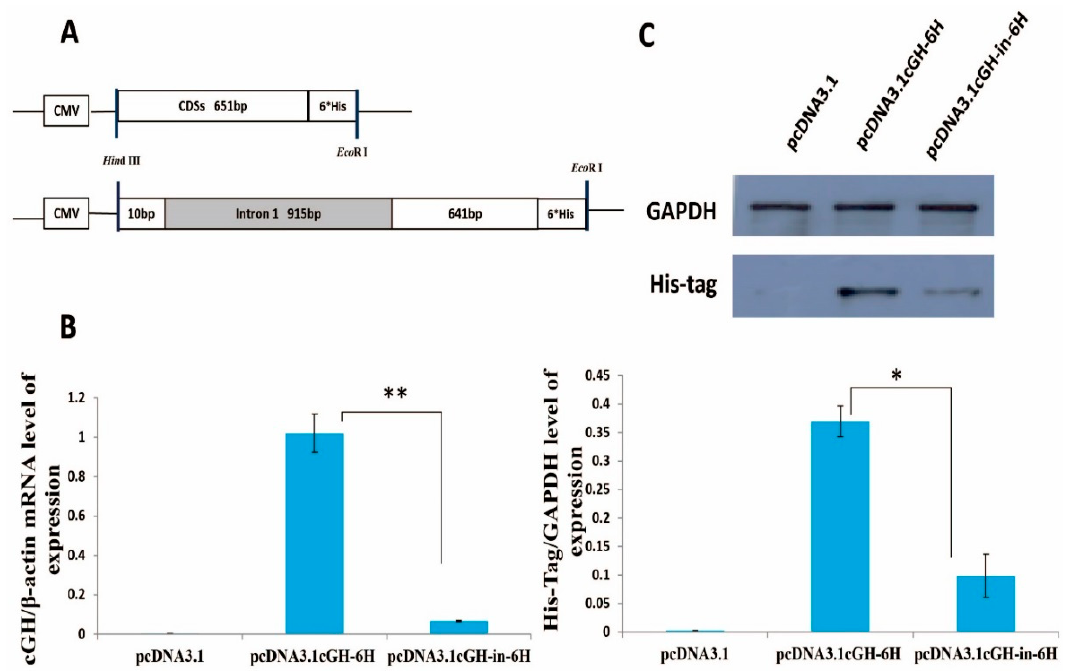
Figure 2. cGH mRNA and protein expression following transfection of the GH4-C1 cell lines. ( A ) Diagrammatic representation of the pcDNA3.1-cGH-6H and pcDNA3.1-cGH-in-6H vectors; ( B ) the mRNA expression level with the qRT-PCR test after the GH4-C1 was treated with vectors for 48 h. The expression level of chicken GH mRNA transfection with pcDNA3.1cGH-in-6H was only 7% relative to pcDNA3.1cGH-6H; ( C ) the protein expression level with the western blot test after the GH4-C1 treated with vectors for 48 h. The expression level of cGH protein transfection with pcDNA3.1cGH-in-6H was only 27% relative to pcDNA3.1cGH-6H. Each data point represents mean ± SEM of three replicates. Asterisks indicate significant difference when comparing the two indicated constructs, * means p < 0.05, ** means p < 0.01. CMV, cytomegalovirus; CDSs, complete coding sequences.